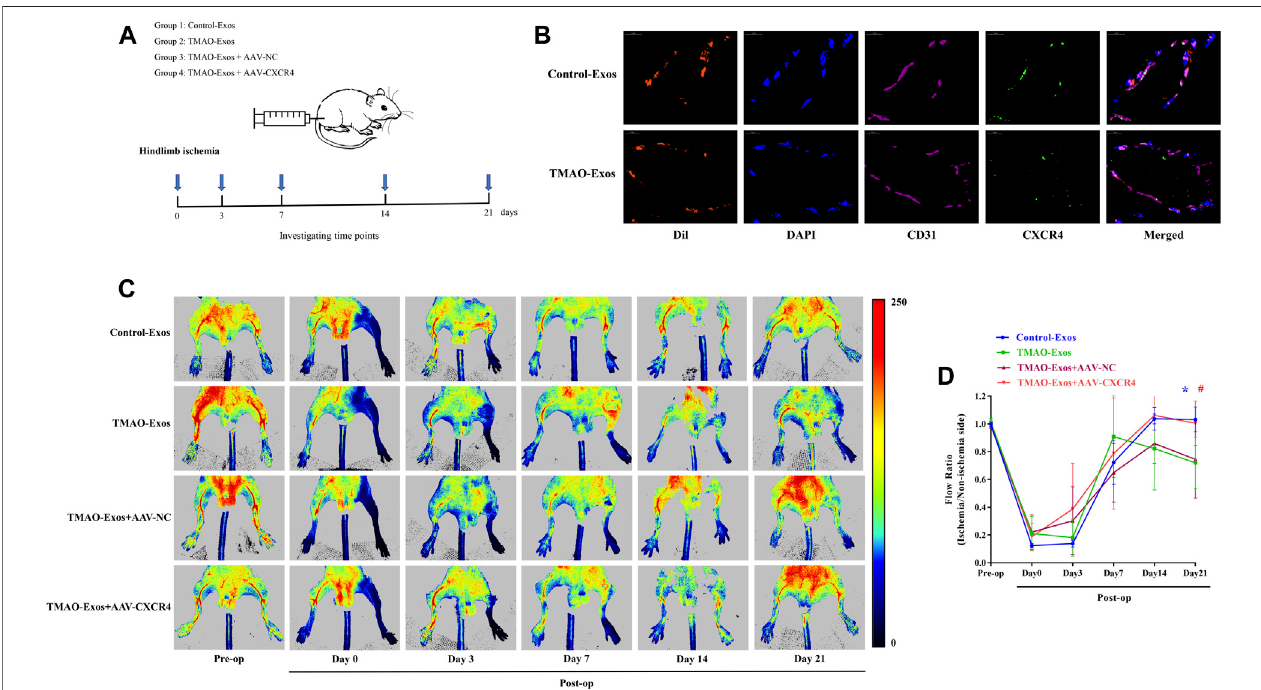
FIGURE 5 | TMAO-Exos suppressed angiogenesis in hindlimb ischemic mice via repressingCXCR4. (A) The schematic representation for experimental work fl ow. (B) RepresentativephotographsofthelocalizationofDiI-labelledExosingastrocnemiusmuscles.Exosfrombothgroupsweremainlyenrichedinendothelialcells,where they were co-located with CXCR4. Nuclei were stained with DAPI. Bar: 10 μ m. (C,D) TMAO-Exos signi fi cantly impeded revascularization at 21 days after ligation of the femoral artery. n = 6, one-way ANOVA followed by LSD test for pairwise comparisons were applied; * p < 0.05, # p < 0.05 versus the TMAO-Exos group and the TMAO-Exos + AAV-NC group. All data were expressed as mean ±